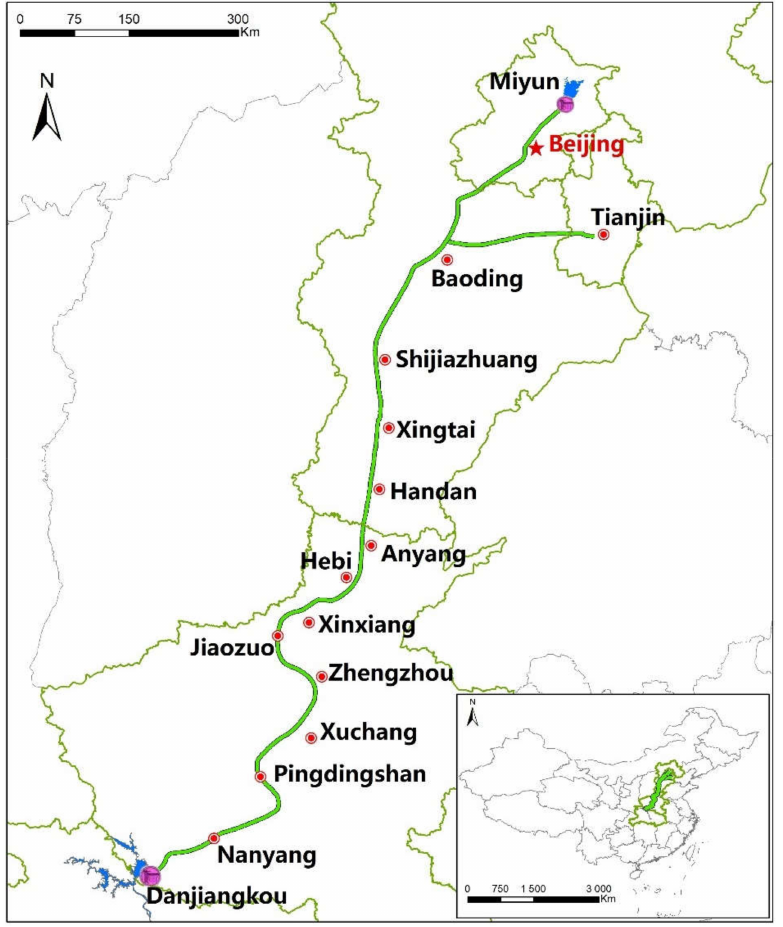
Figure 2. The middle route of the South-to-North Water Diversion